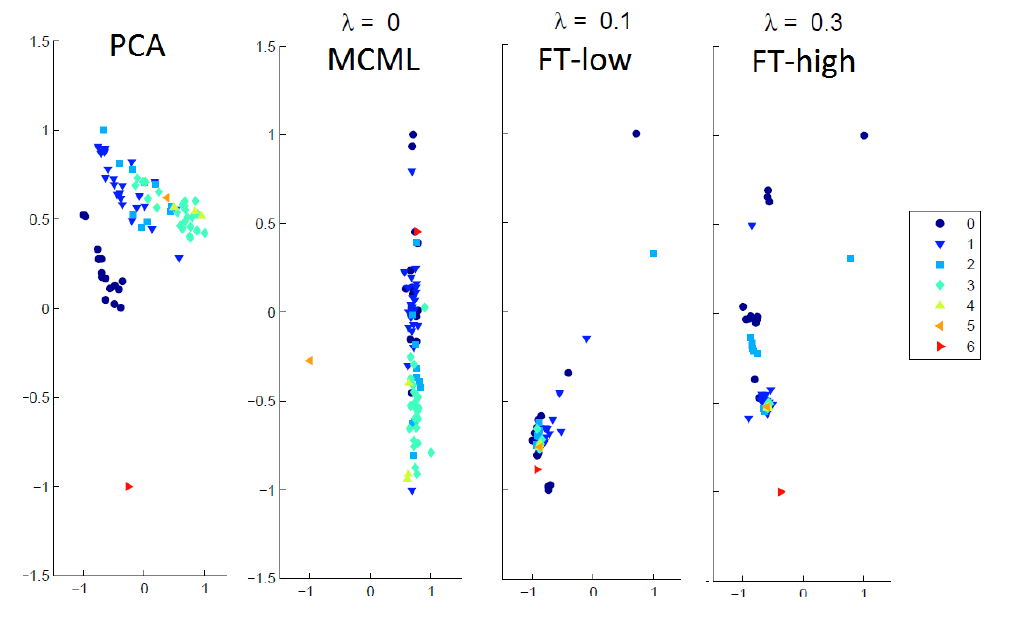
Figure 3. The four conditions of the HIV dataset. Please note the data point colour and shape are for illustration only and they are not used in the actual experiment. It is not easy to recognize that these four projections are the same dataset, even when placing them next to each other with the colour and shape. So when they appear randomly and without colour or shape, the chance that a participant could recognize them during the experiment was very